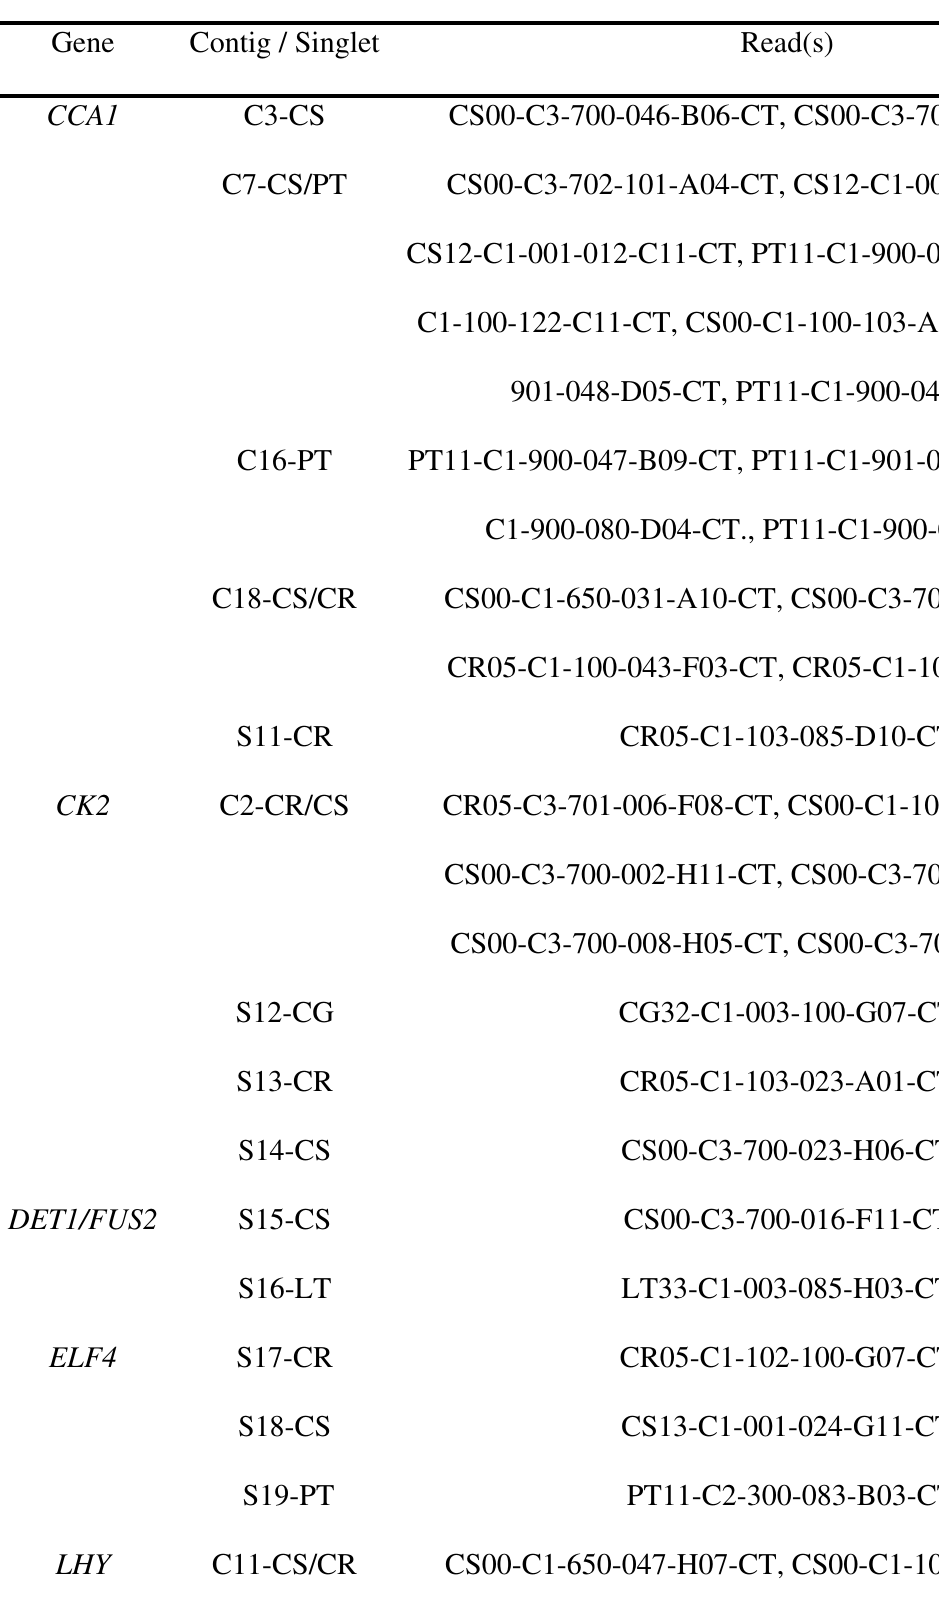
Table 2S - Citrus reads constituting contigs and singlets with homology to genes involved in the central oscillator of the circadian clock in Arabidopsis thaliana